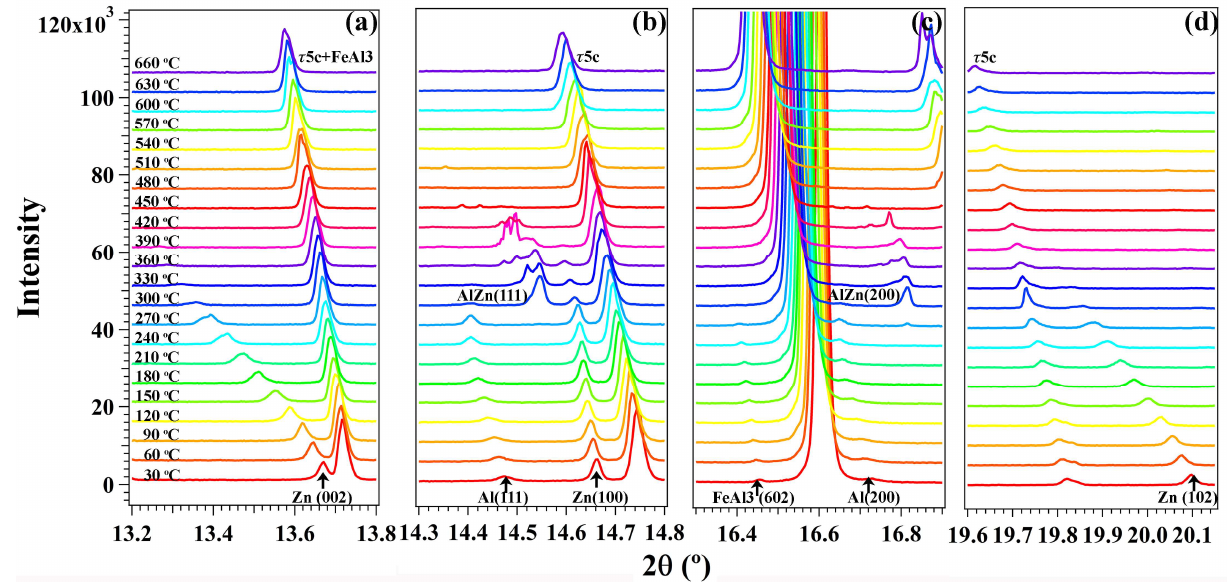
Figure 2. The XRD patterns to highlight the lattice plane reflections for ( a ) β -Zn(002), ( b ) α -Al(111), ( c ) α -Al(200) and ( d ) β -Zn(102). The strongest diffraction peaks are indexed to be the overlapped reflections of τ 5c(431)+(510)+(501) and FeAl 3 (13 2)+(223)+(22 4) in ( a ); τ 5c(521)+(512) in ( b ); τ5c(523)+(532)+(611) in ( c ) and τ5c(721)+(712)+(552)+(633) in ( d ). The XRD patterns at different temperatures are offset for the clarity.